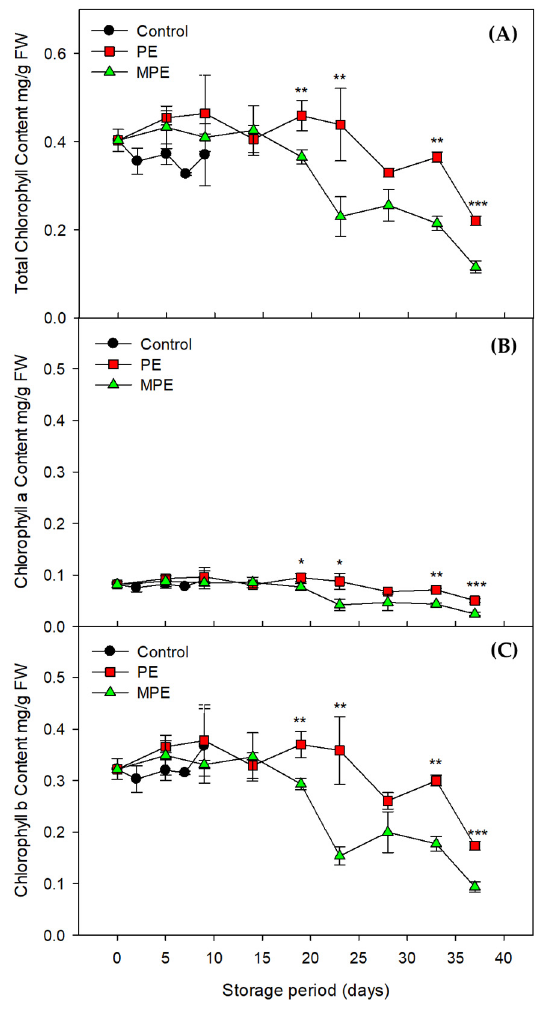
Figure 2. Total chlorophyll content ( A ), chlorophyll a content ( B ), and chlorophyll b content ( C ) of G. littoralis during storage at 4 °C. MAP treatment was classified into micro-perforated PE (MPE, 32 pinholes) and PE on the basis of the presence or absence of pinholes, respectively. Values are shown as mean ± standard deviation. Statistical significance was shown by a t -test between PE and MPE at each time point during storage (*** p < 0.001, ** p < 0.01, and * p <